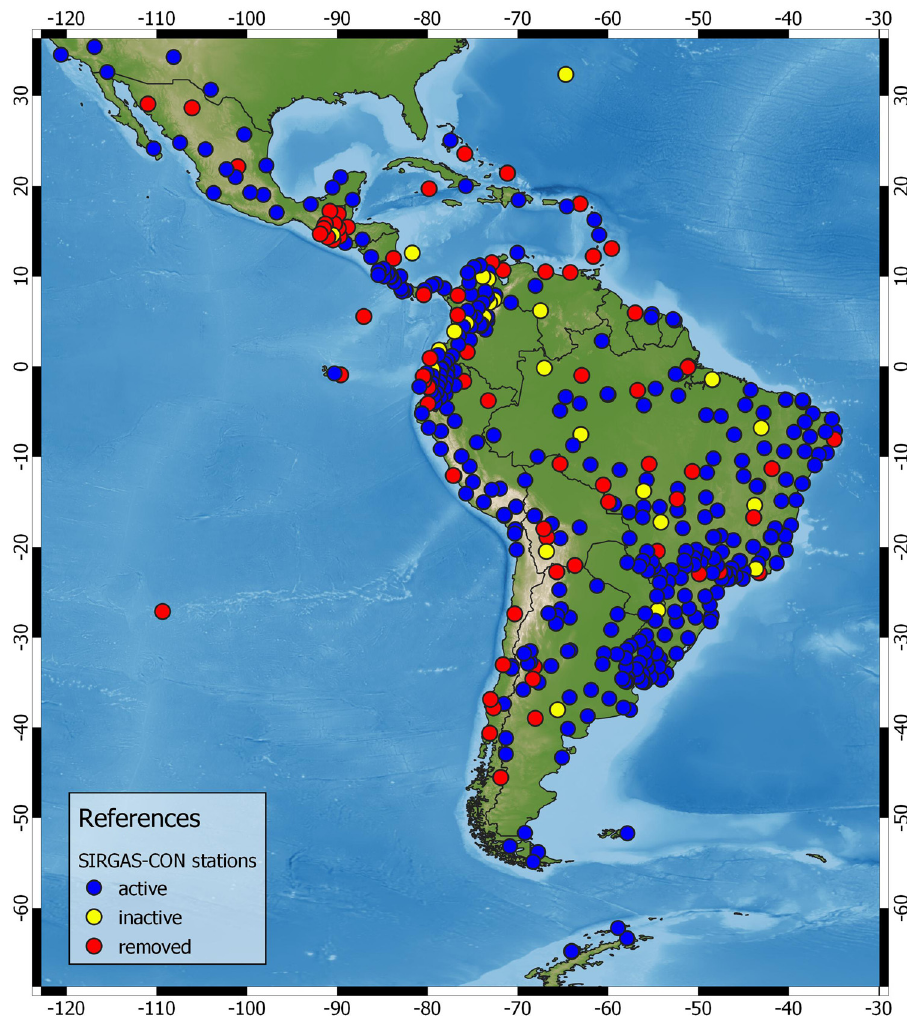
Figure 1: SIRGAS - CON GNSS stations, status at April